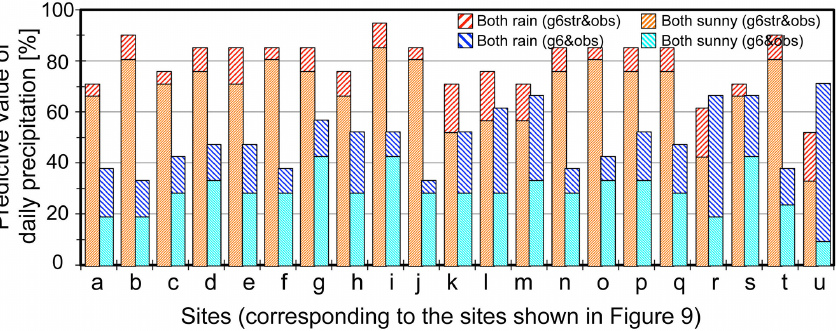
Figure 10. Predictive values of daily precipitation using the NICAM-g6str and NICAM-g6 simulations and the AMeDAS measurements during August 2007 at the sites defined at Fig. 9, in units of percentage. Table 2. Statistical values (averages of the observation and simulations, correlation coefficient R and root mean square error RMSE) for EC, sulfate, and SO 2 concentrations by the simulations (NICAM-g6str, NICAM-g6, and WRF-CMAQ) and the observations at four FAMIKA sites during the period from 6 to 11 August. The WRF-CMAQ results are given by Shimadera et al. (2013). Maebashi Kisai Komae